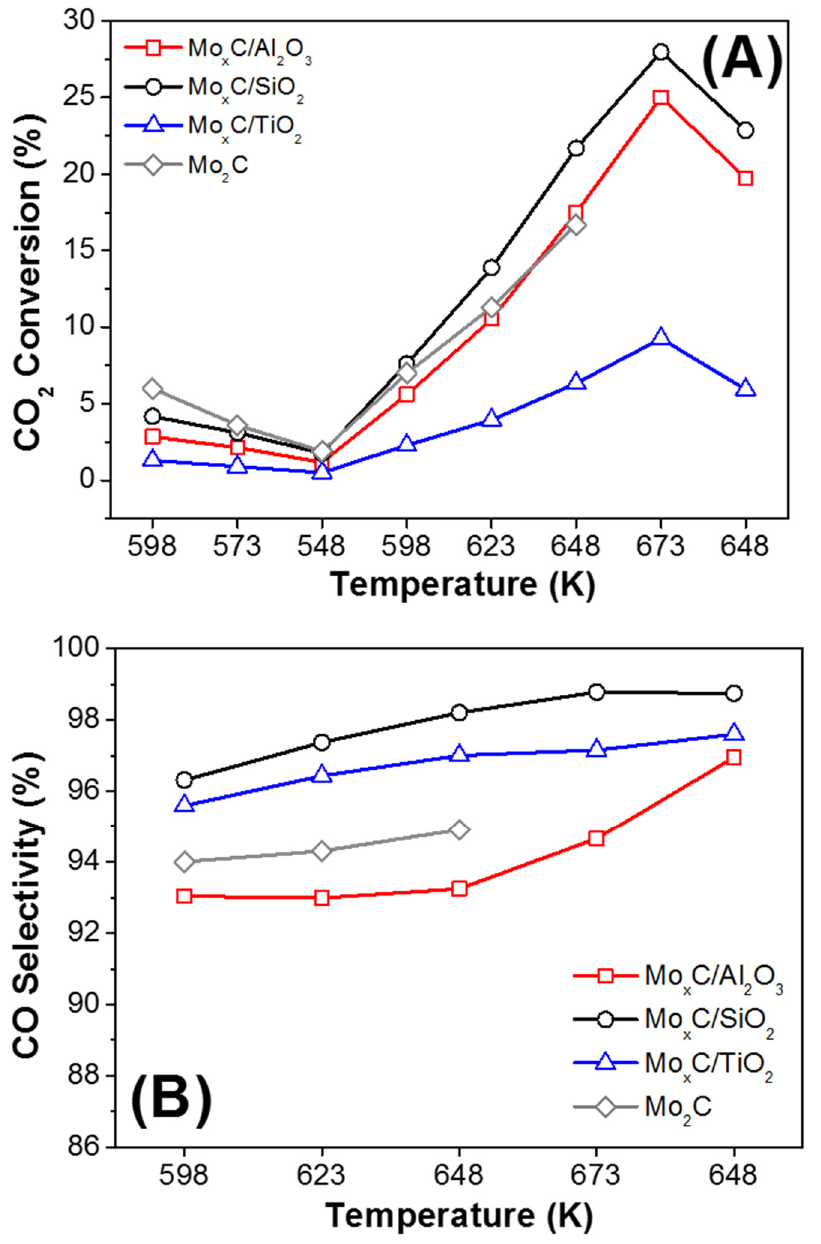
Figure 8. Catalytic behavior of Mo x C/support and unsupported reference Mo 2 C catalysts in the RWGS reaction as a function of reaction temperature; ( A ) CO 2 conversion, ( B ) CO selectivity. Reaction conditions: m cat = 150 mg, CO 2 /H 2 /N 2 = 1/3/1, GHSV = 3000 h − 1 , P = 0.1 MPa.